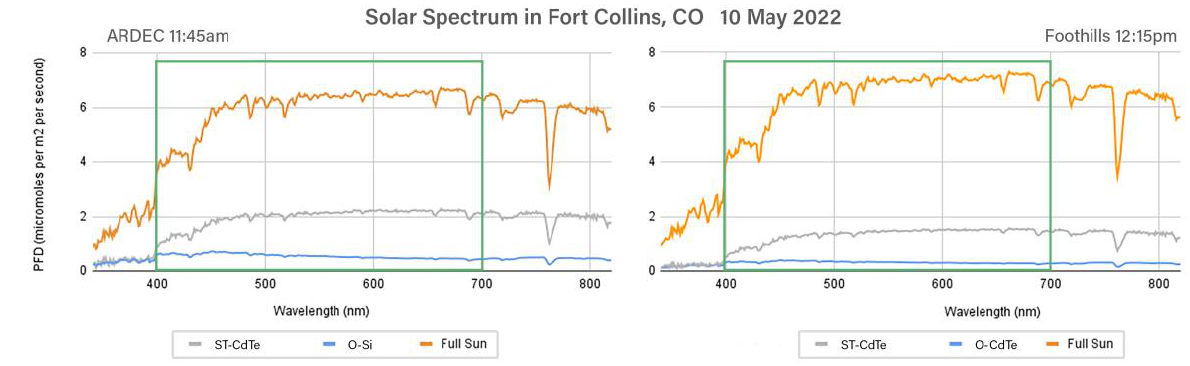
Figure 4. Spectroradiometer readings (ARDEC, 2022/Foothills, 2022). In Figure 4, the green rectangle delineates light in the PAR range (PPFD) from other wavelengths of light. The spectroradiometer readings from ARDEC and Foothills show similar patterns of PPFD between the full sun and under-PV panel types. Both types of PV panels allowed all light wavelengths through, but with varying intensity. At ARDEC at 11:45 pm on 10 May 2022, the average PPFD in full sun was 1816, while it was 601 under ST-CdTe and 163 under O-Si. At Foothills at 12:15 on 10 May 2022, the average PPFD in full sun was 1970, while it was 405 under ST-CdTe and 92 under O-CdTe. Ultraviolet (UV) light in the 10–400 nm wavelengths was also notably absorbed by the PV